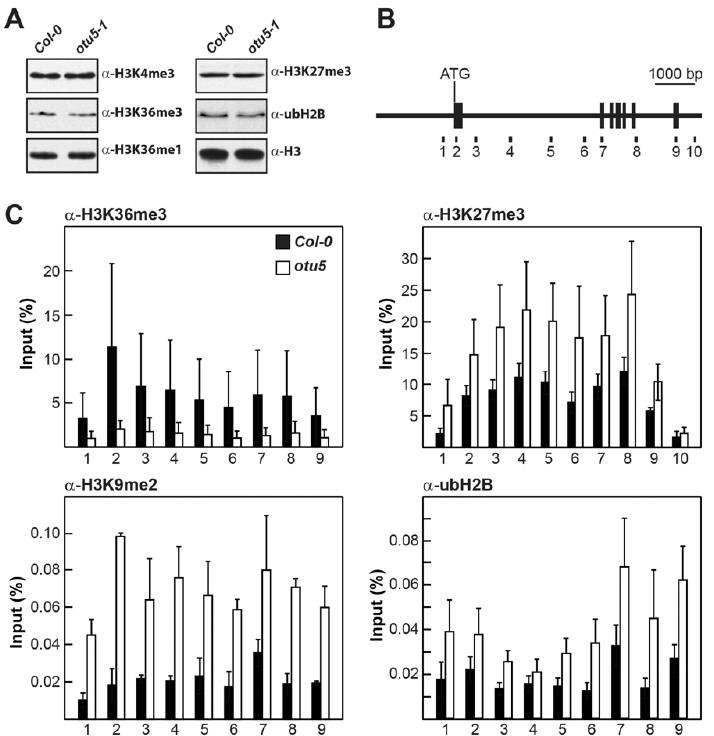
Figure 4. Global and FLC -associated levels of major activating and repressive histone marks in otu5-1 plants. ( A ) Global levels of various histone marks, including H3K4me3, H3K36me3, H3K36me1, H3K27me3, and ubH2B, of nuclear-enriched protein extracts prepared from ten-day-old Col-0 and otu5-1 seedlings were examined by immunoblotting using antibodies as indicated. Levels of histone 3 (H3) were examined as a loading control. ( B ) A schematic diagram in scale of the FLC gene structure depicts 10 amplification regions (bars) labeled 1–10 that were analyzed by qChIP. Sequences upstream of the start codon (ATG), downstream of the stop codon, and introns are represented by lines; exons are indicated by boxes. The corresponding primer pairs are listed in Table S4. ( C ) The percentage qChIP amplification yields, in comparison with those amplified from input DNA, from 9–10 FLC regions using various antibodies, as indicated against H3K36me3, H3K27me3, H3K9me2, and ubH2B for otu5-1 and Col-0 seedlings. Error bars indicate standard deviations. The levels of activating and repressive histone marks on MAF4 and MAF5 in otu5-1 were also examined by qChIP with four to six selected regions in various exons and introns covering their full coding regions (Figure 5A, primer pairs 1–6 for MAF4 and Figure 5B, primer pairs 1–5 for MAF5 ). Slightly reduced levels of the activating histone mark H3K36me3 in two tested regions located in the first introns of MAF4 (primer pairs 3 and 4) and MAF5 (primer pairs 2 and 3) were observed in otu5-1 plants (Figure 5C,D, α -H3K36me3). In contrast, the levels of the repressive histone marks H3K27me3